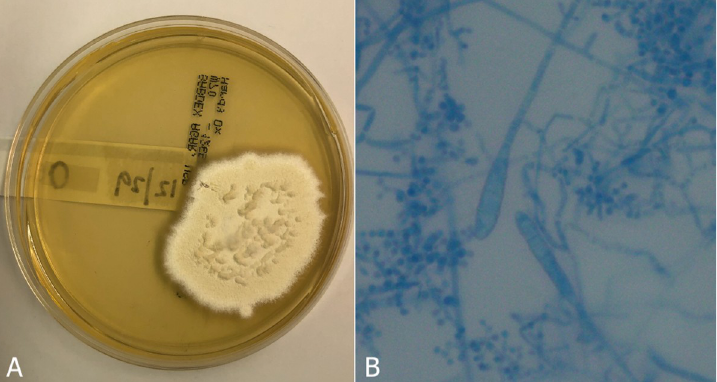
Fig 2. Trichophyton spp . dermatophyte. (A) Macroscopic identification of Trichophyton spp . dermatophyte. Grown at 23˚C on SDA with an irregular form, flat, and undulate margins. Texture appears granular and is white in color. (B) Microscopic identification of Trichophyton spp . dermatophyte. Two club-shaped macroconidia and multiple spherical microconidia in clusters.